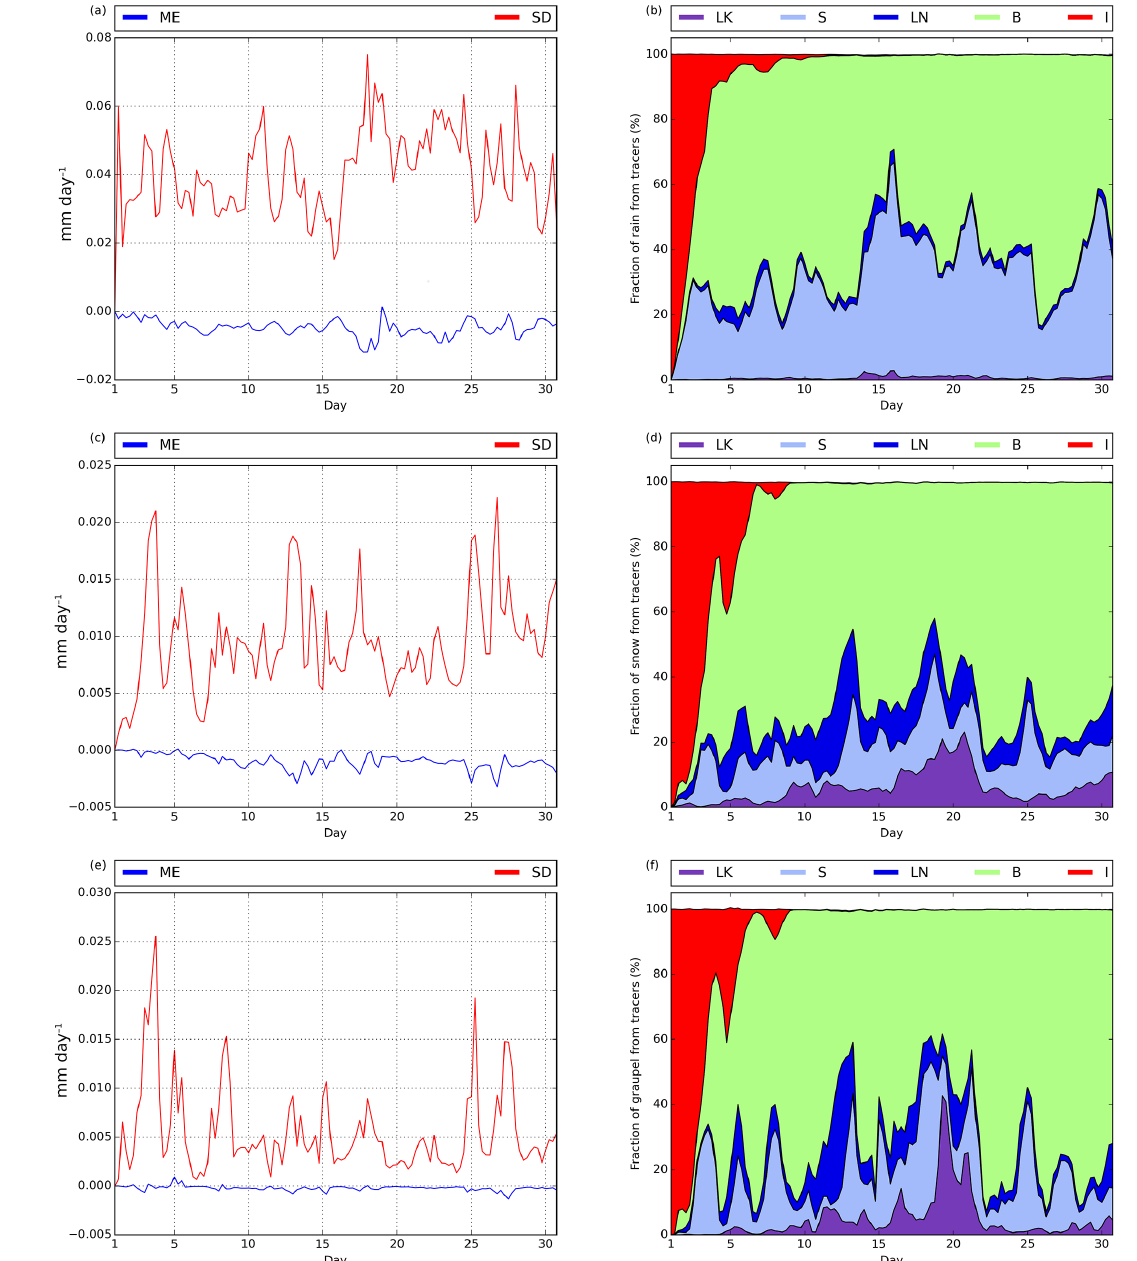
Figure 6. Mean error (blue) and standard deviation (red) (mm) for 3h accumulated tracer rain (a) , tracer snow (c) and tracer graupel (e) . Relative contribution of each moisture source [lake evaporation (LK, purple), sea evaporation (S, light blue), land evapotranspiration (LN, dark blue), lateral boundary advection (B, green), initial moisture (I, red)] to 3h accumulated rain (b) , snow (d) and graupel (f)